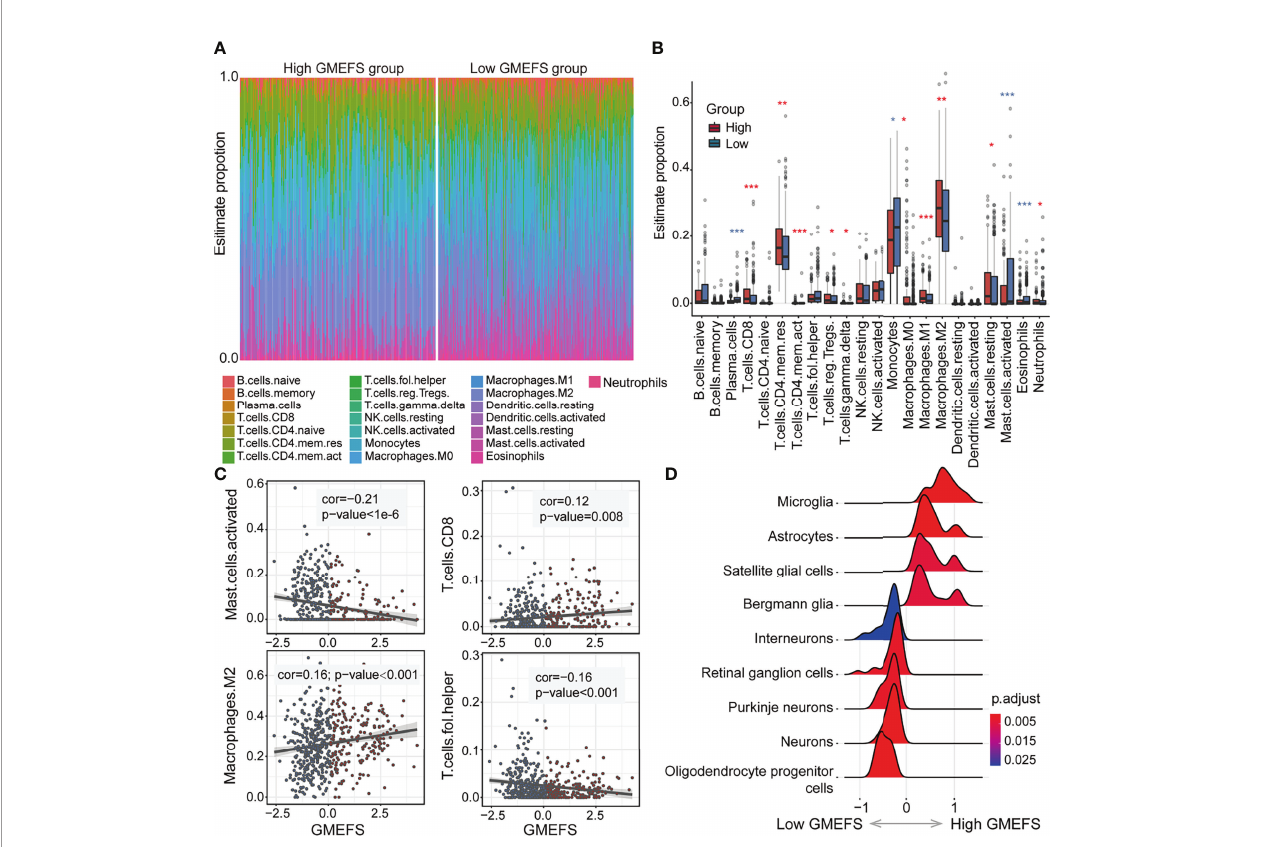
FIGURE 4 | Immune cell proportion analyses of the two GMEFS groups in TCGA-LGG. (A) Relative proportions of immune in fi ltration for 22 signatures in the high and low GMEFS groups. (B) Boxplots illustrate the 22 immune cell proportions in TCGA-LGG. (C) The associations between the GMEFS score and in fi ltration score of activated mast cells, CD8 T cells, M2 macrophages, and T helper cells. (D) The GSEA analysis for cell markers from PanglaoDB database between the high and low GMEFS groups. *, 0.01<p; **, 0.001<p; ***,